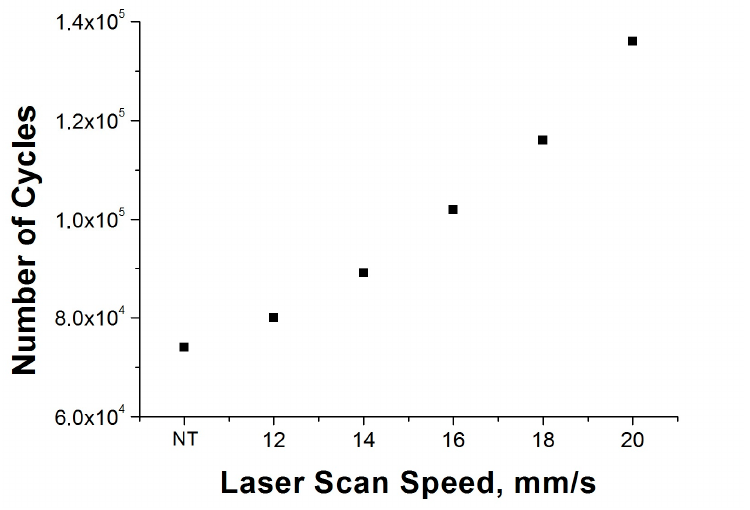
Figure 6. Number of cycles vs. laser scan speed (Laser power = 200 W). NT refers to the untreated samples.